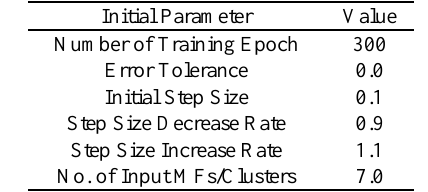
Table 1. Initial parameter values of the proposed ANFIS for training phase